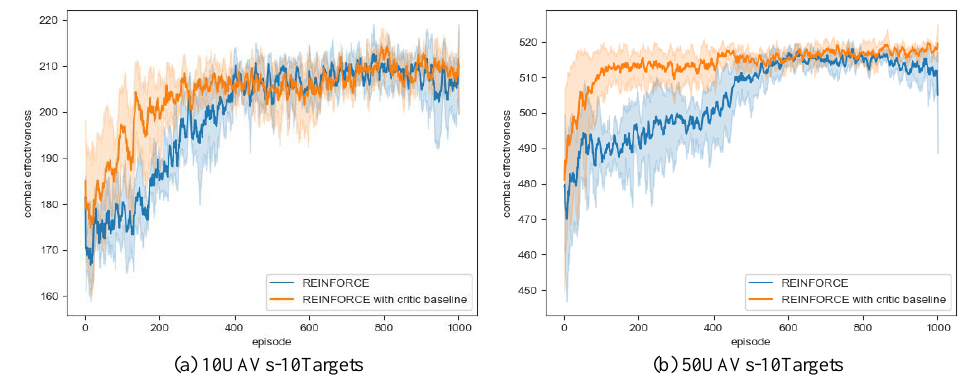
Figure 3. Curves of combat effectiveness with respect to training